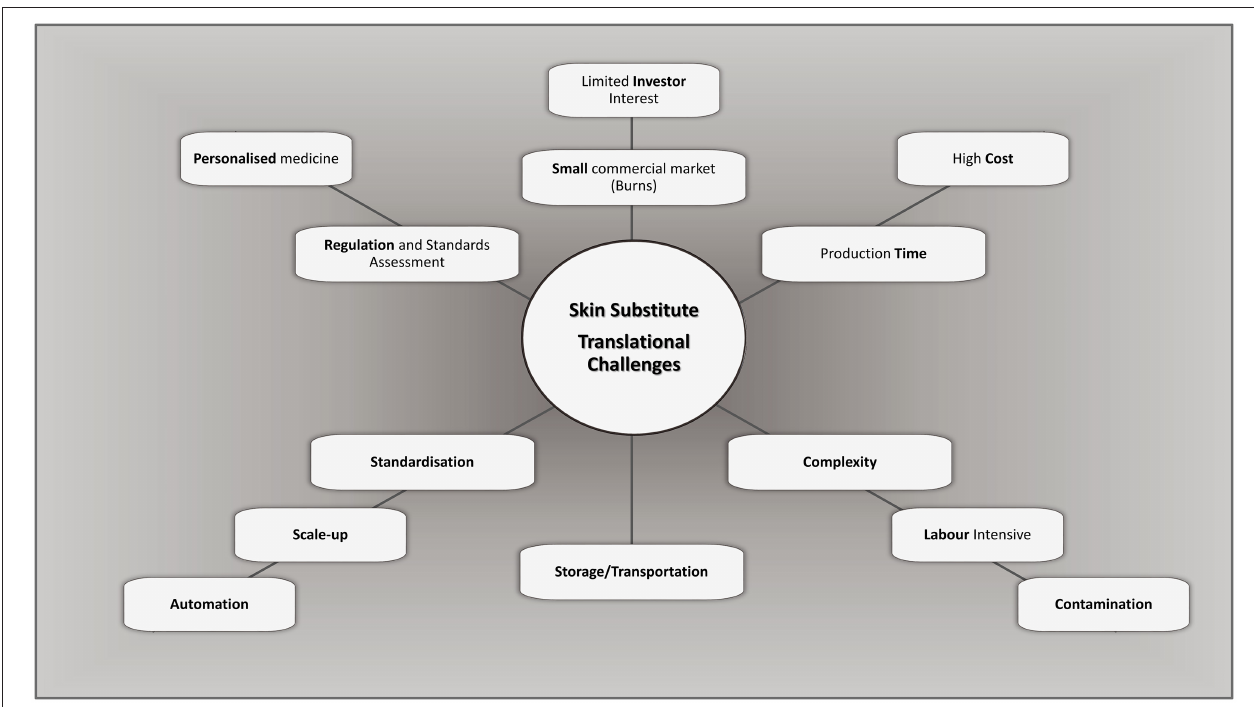
FIGURE 1 | Challenges and considerations in bioengineering of bilayered skin substitutes. Adapted from Al-Himdani et al. (133).